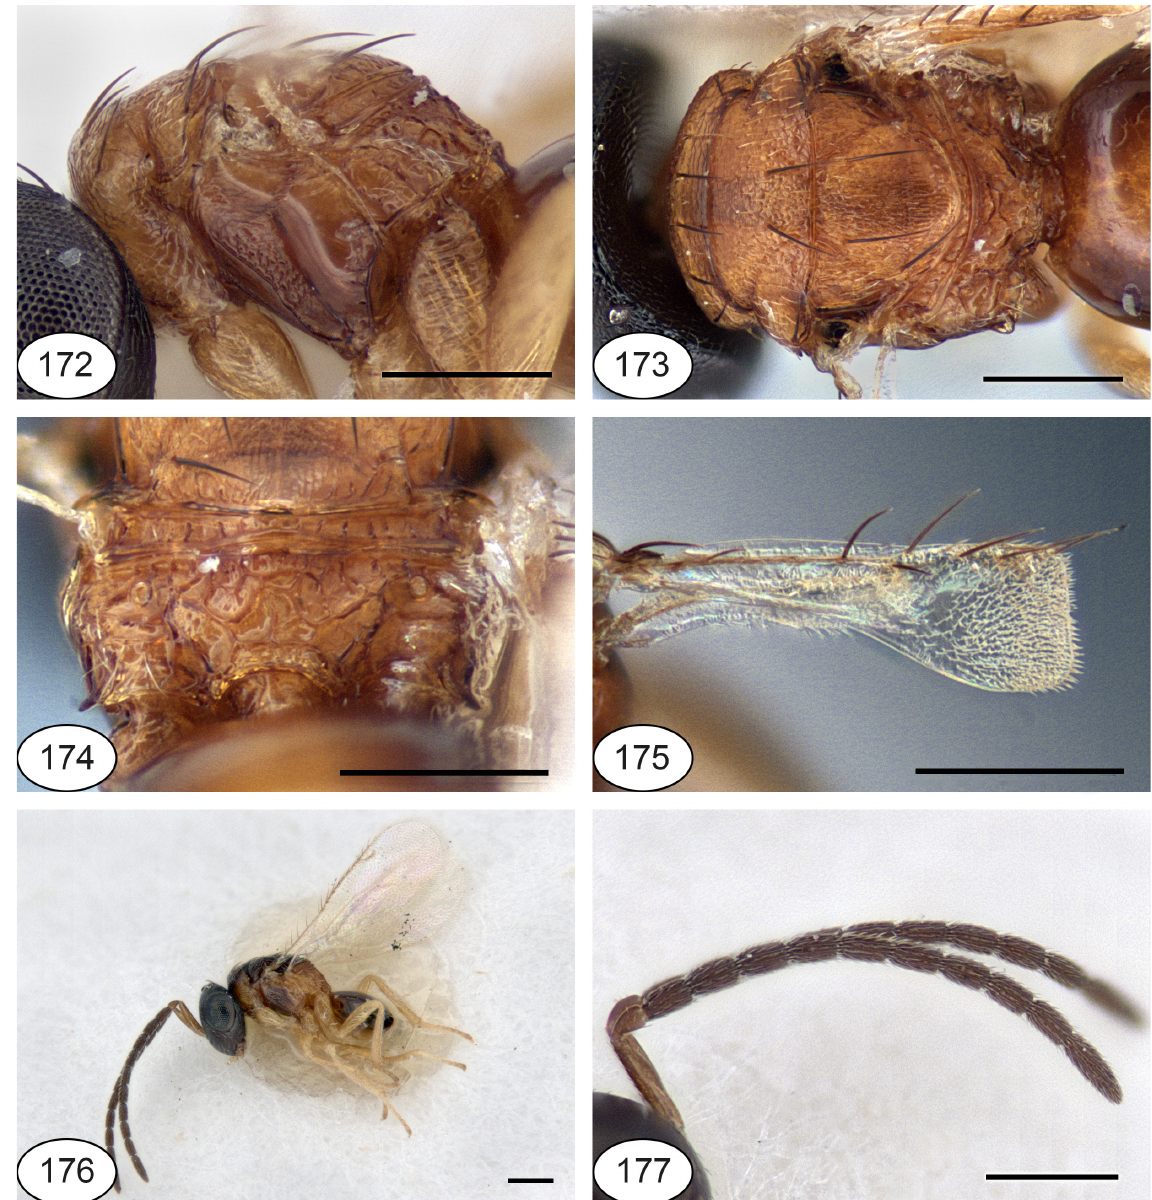
Figs 172–177. Netomocera sedlaceki Bouček, 1988. 172 . Paratype, ♀, mesosoma, lateral view. 173 . Paratype, ♀, mesosoma, dorsal view. 174 . Paratype, ♀, propodeum, dorsal view. 175 . Paratype, ♀, fore and hind wings. 176 . Paratype, ♂, habitus, lateral view. 177 . Paratype, ♂, antenna. Scale bars: 0.2